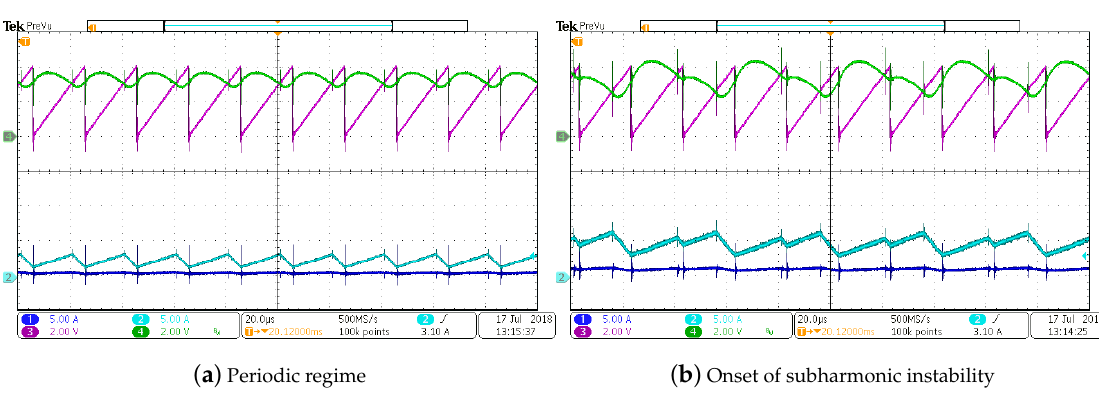
Figure 16. Experimental waveforms of the quadratic boost converter fed by a PV generator before (S = 500 W/m 2 ) and after (S = 750 W/m 2 ) subharmonic oscillation takes place. V M = 4 V. Θ = 25 ◦ C. Other parameters’ values are from Table